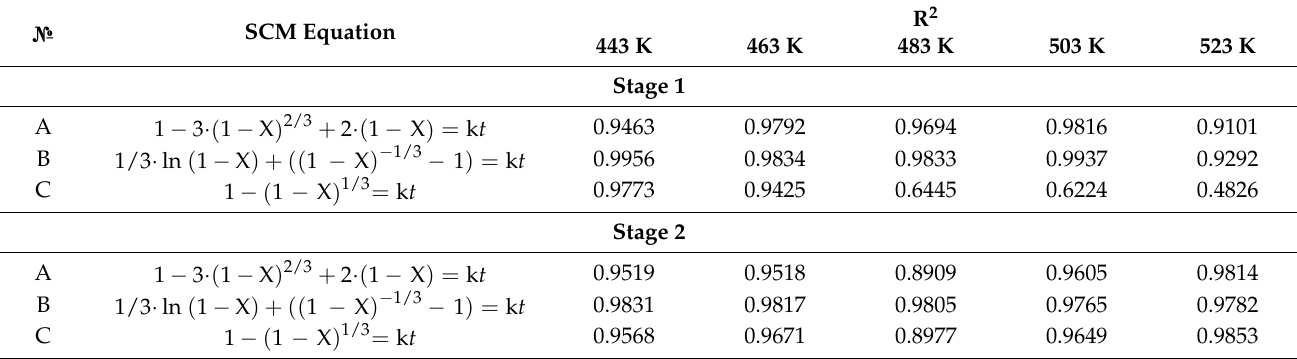
Table 6. SCM equation fitting for determined